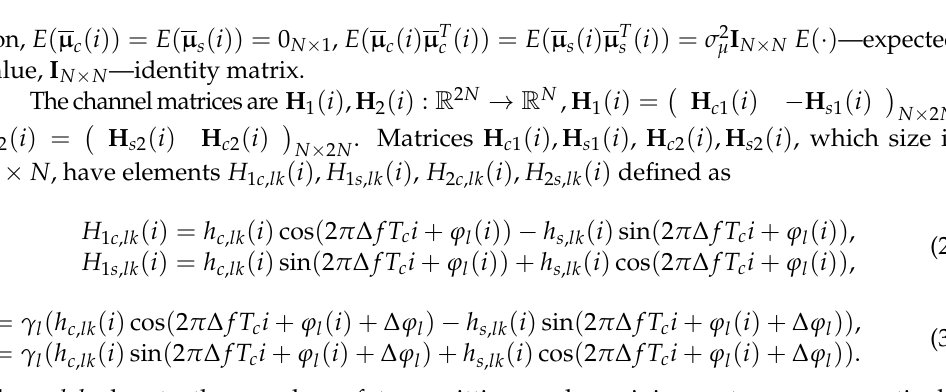
Table 2. Parameters of the channel and signal distortion in the direct conversion receiver. Parameter Description γ l Amplitude imbalance between IQ components at the l -th receiving antenna ∆ ϕ l Phase imbalance between IQ components at the l -th receiving antenna b cl , b sl DC offsets of IQ components at l -th receiving antenna ∆ f The frequency offset after demodulation h c , l k ( i ) , h s , l k ( i ) Time-varying channel gains ϕ l ( i ) = ϕ l 0 + ζ l ( i ) Phase of the signal ζ l ( i ) Phase noise ϕ l 0 An initial random phase T